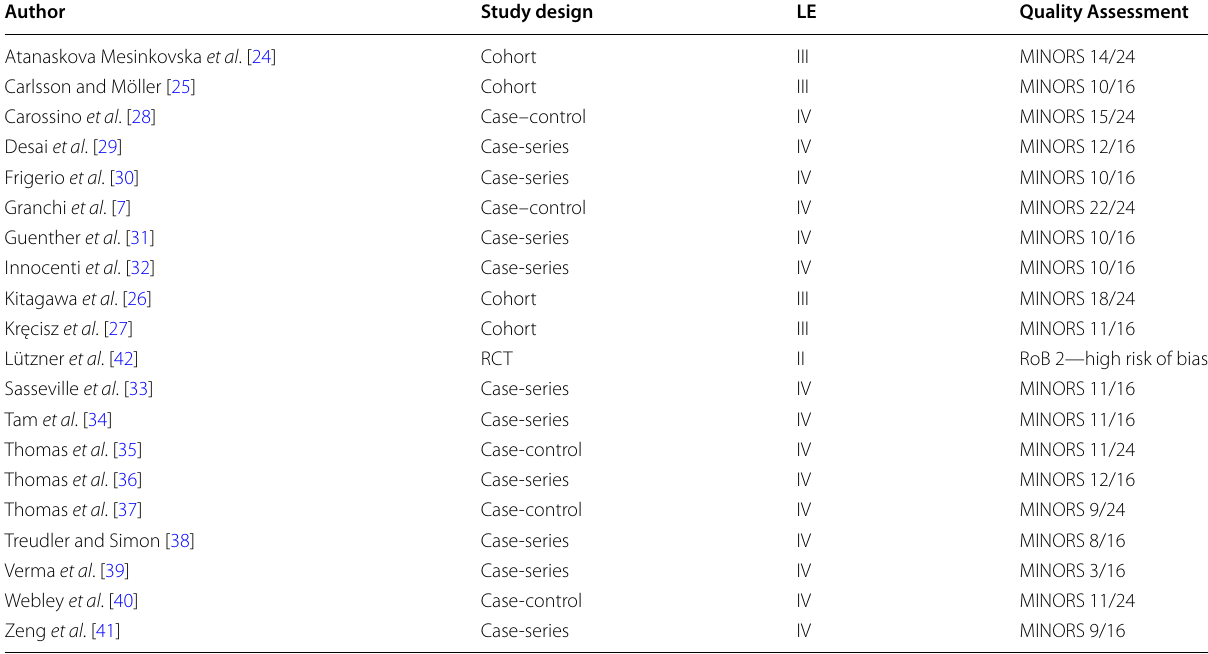
Table 1 Study design, level of evidence (LE) and Quality Assessment Score (MINORS for observational studies, RoB 2 for randomized